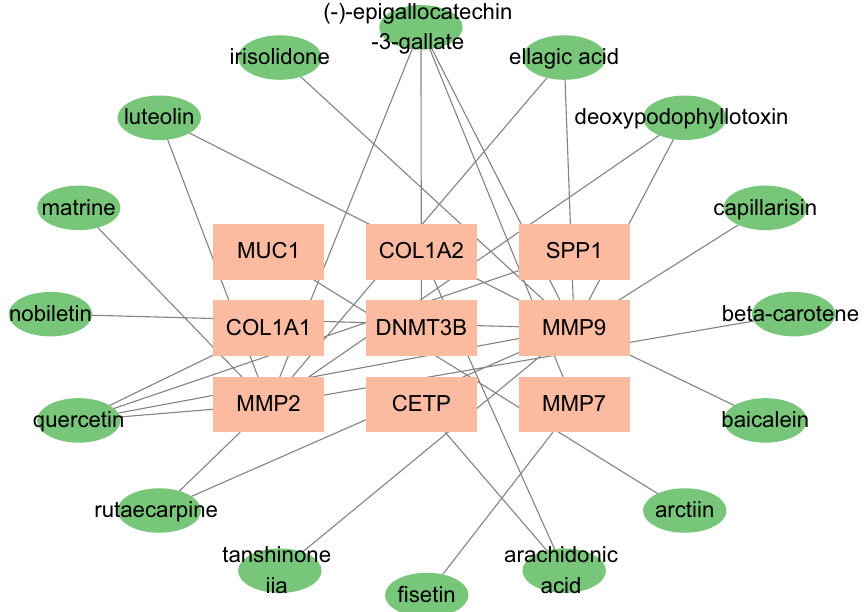
Figure 6. Ingredients-Targets network. Nine orange nodes represent the target genes, whereas the 16 green nodes represent the active compounds. The edges represent the interaction between the compounds and